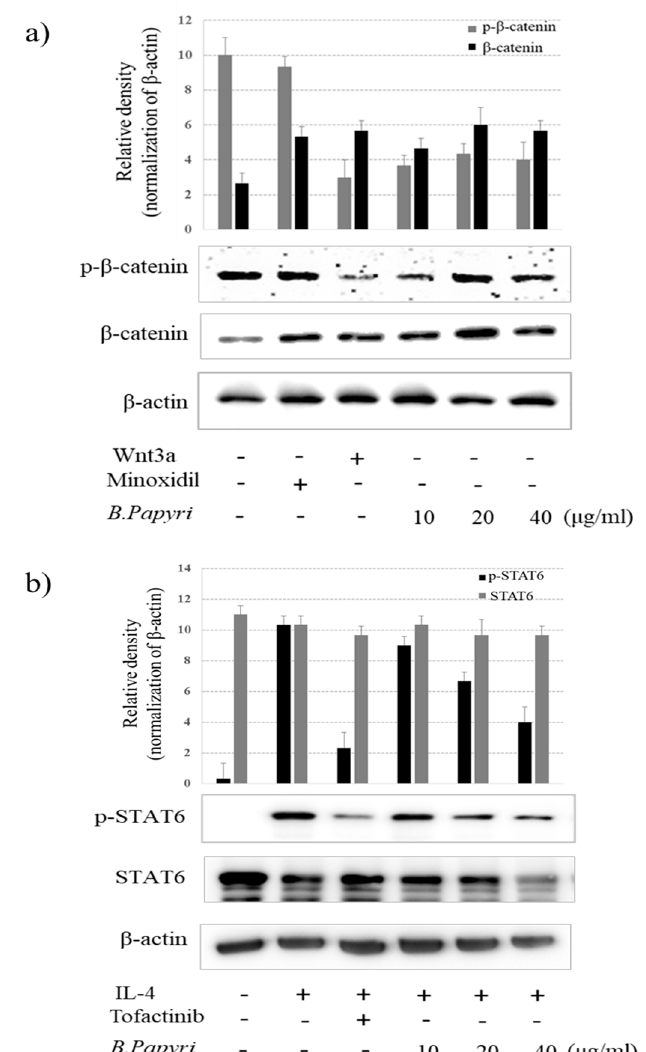
Figure 3. E ff ect of B. papyrifera on the level or activity of proteins implicated in hair growth. ( a ) The level of p- β -catenin and β -catenin was detected by Western blotting using specific antibodies in hHF DP cells; ( b ) The level of p-STAT6 and STAT6 was detected by Western blotting using specific antibodies in IL-4-induced HDPCs; ( c ) The level of p-STAT3 and STAT3 was detected by Western blotting using specific antibodies in IL-6-induced HDPCs. β -Actin protein was used as an internal control. Immunoblot assay was performed as described in the Materials and Methods. Each blot is representative for 3 experiments.